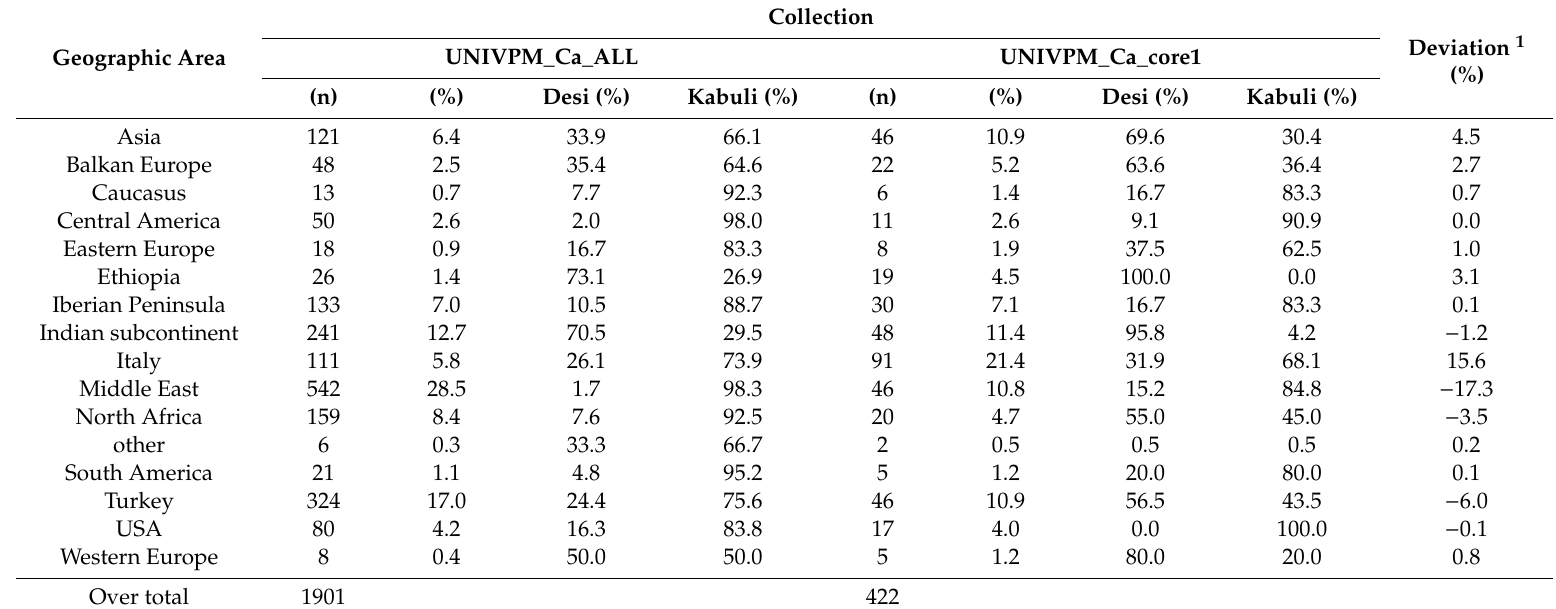
Table 2. Proportions of accessions belonging to the desi and kabuli types for each geographic area for UNIVPM_Ca_ALL and UNIVPM_Ca_core1 .